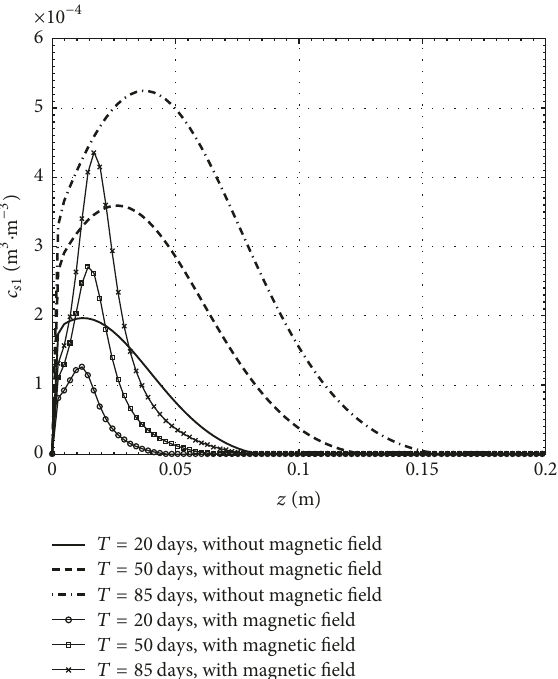
Figure 12: Pore wall deposited nanoparticles concentration against core length with and without magnetic field effect for various values of imbibition time: magnet is placed on the left side of the core.